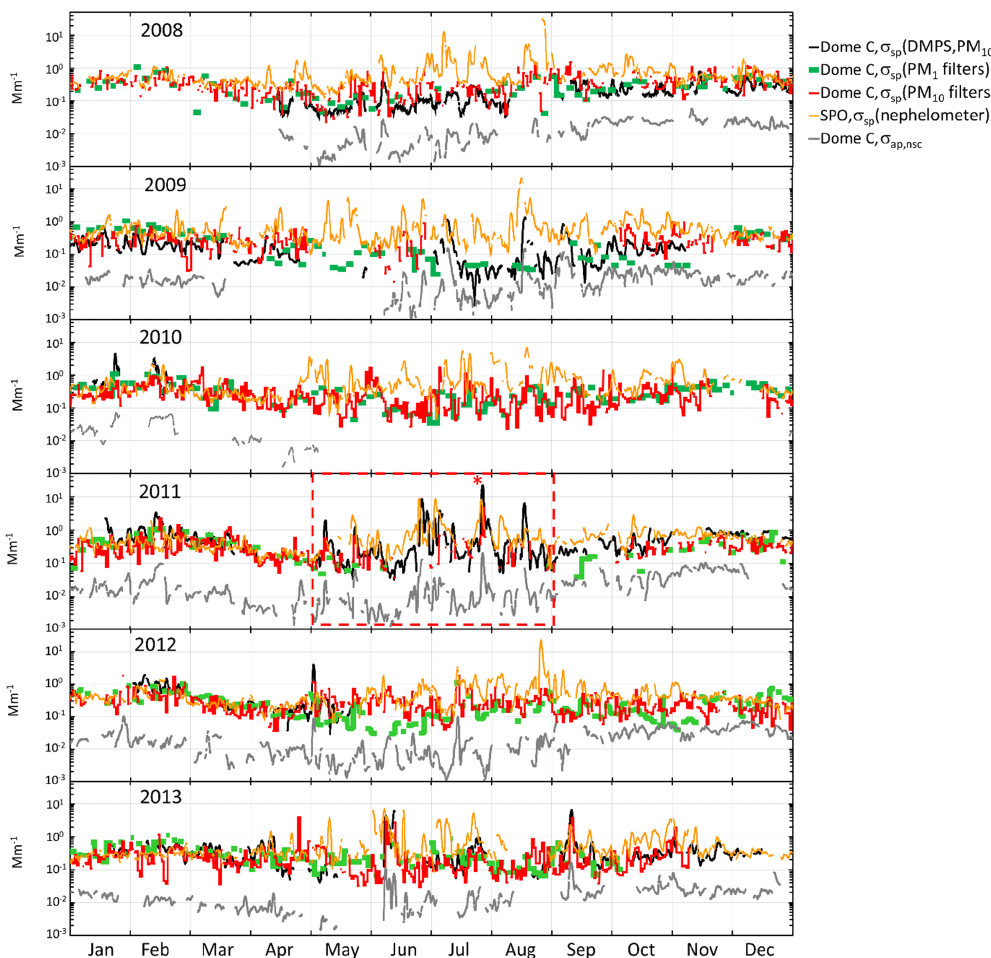
Figure 5. Time series of scattering coefficients calculated from the DMPS ( σ sp (DMPS,PM 10 ) at λ = 530), PM 1 and PM 10 ( λ = 550) filter data measured at Dome C and measured with the nephelometer at the South Pole Station (SPO) ( λ = 550), and σ ap,nsc ( λ = 530) measured with the PSAP at Dome C. The σ sp from the DMPS and the nephelometer and σ ap,nsc are running 24h averages at each hour ( ± 12h), and the σ sp from the PM 1 and PM 10 filters are those calculated for each filter. The red box within the 2011 time series shows the period presented in more detail in Fig. 6 and the red asterisk symbol (*) for which the footprint in Fig. 7 was